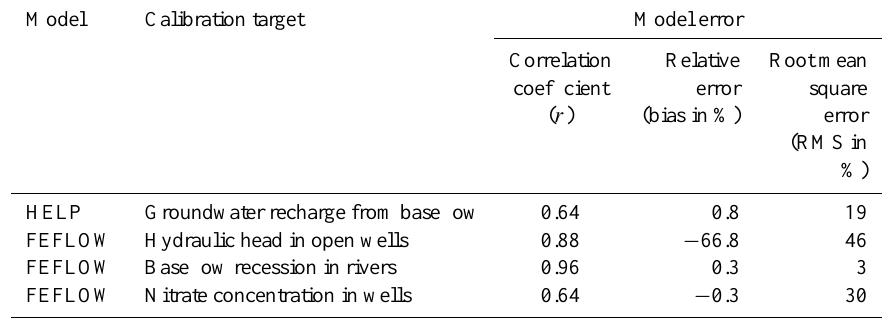
Table 4. Statistical analysis of model performance on calibration of different independent data sets for the simulation of groundwater flow and nitrate transport in the Prince Edward Island aquifer